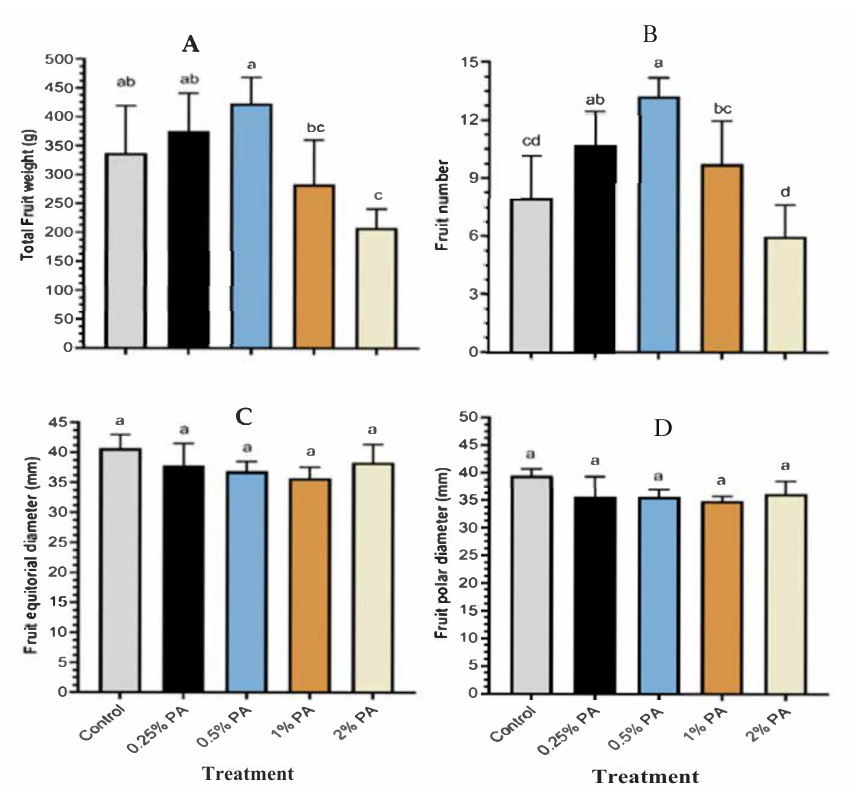
Figure 2. Fruit yield of tomato ‘Scotia’ in response to pyroligneous acid treatment: ( A ) total fruit weight, ( B ) fruit number, ( C ) fruit polar diameter, and ( D ) fruit equatorial diameter. Values are the means of four replicates and different lowercase alphabetical letters indicate significant ( p < 0.05) difference according to Fisher’s least significant difference (LSD) post hoc test. Error bars show the standard deviations. Table 3. Chemical quality of tomato ‘Scotia’ fruits from plants treated with pyroligneous acid (PA).